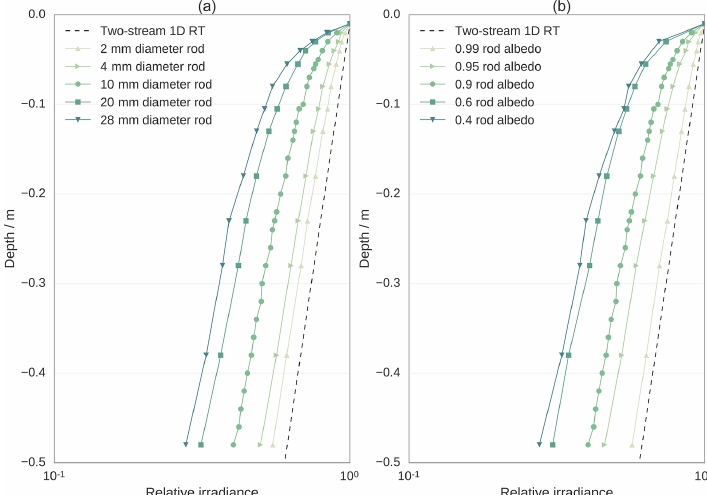
Figure 10. Influence of the (a) rod diameter and (b) rod albedo on the log-radiance profiles at 400nm simulated by MCML for a homogeneous snowpack with SSA of 30m 2 kg − 1 and density of 350kgm − 3 . The 1-D model shows the reference profile in the ideal case (no rod).